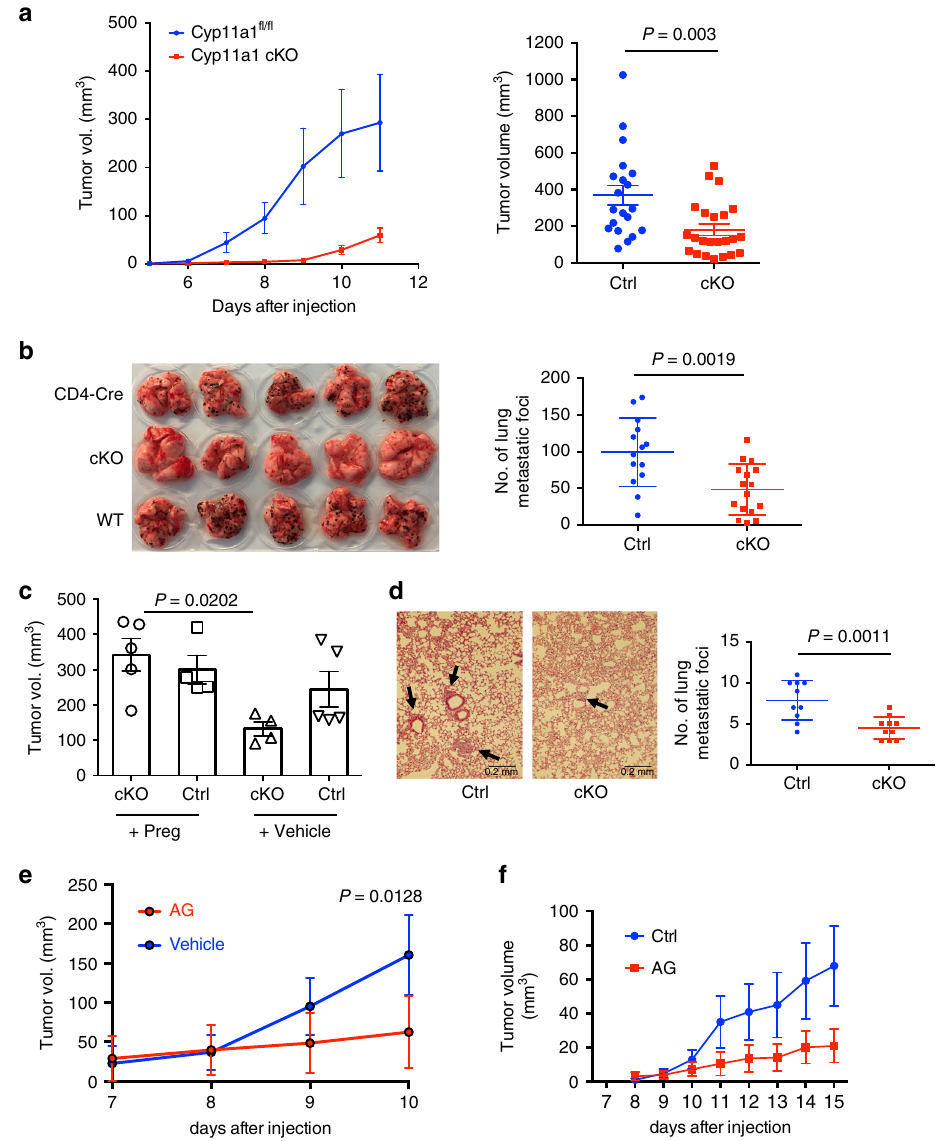
Fig. 5 Ablation of T cell steroidogenesis restricts experimental tumor growth and metastasis. a Left-panel: B16-F10 subcutaneous tumor growth curve assessed in T cell-speci fi c Cyp11a1 cKO (cKO) and Cd4 -Cre control mice. N = 5. Representative of four independent experiments. Right panel: graphical presentation of end-point tumor volume. N = 20 (ctrl), 23 (cKO). Pooled data of four independent experiments. Each point represents an individual